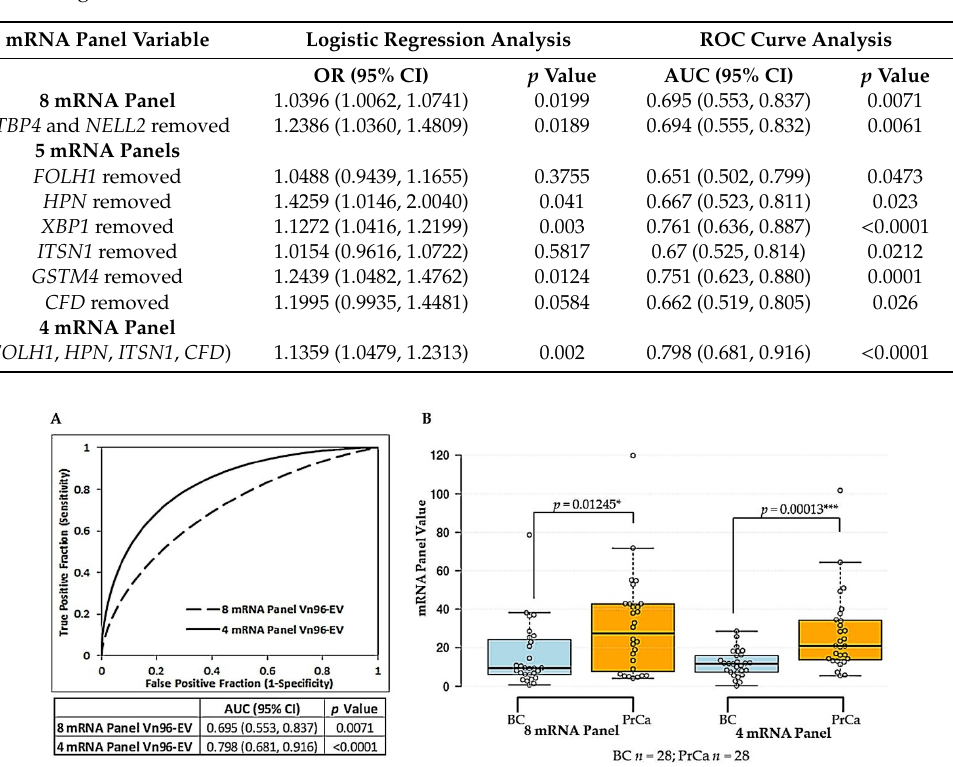
Table 2. Predictive and diagnostic performance of reference-free mRNA biomarker panels for prostate cancer using Vn96-isolated EVs.